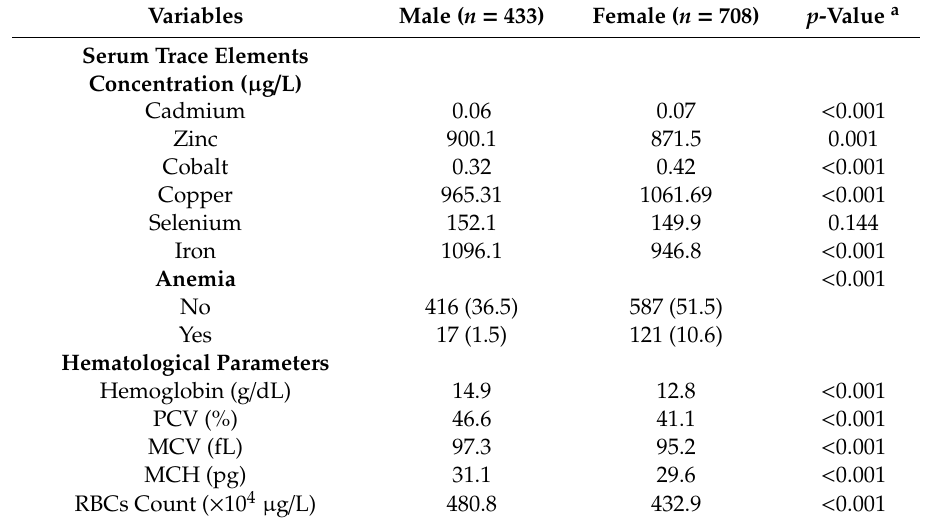
Table 2. Sex di ff erences in trace elements concentration and hematological parameters ( n = 1141). Variables